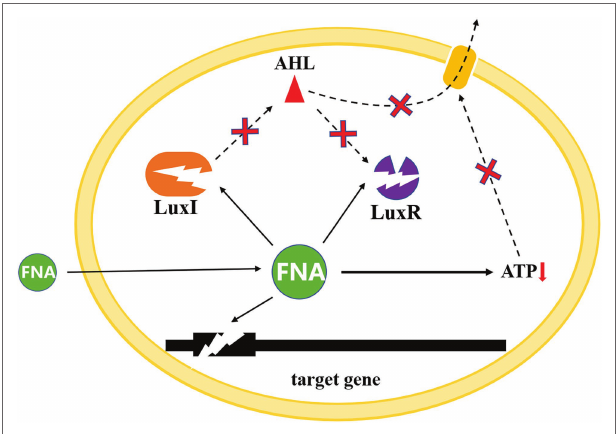
FIGURE 4 | Potential mechanisms of FNA effect on QS